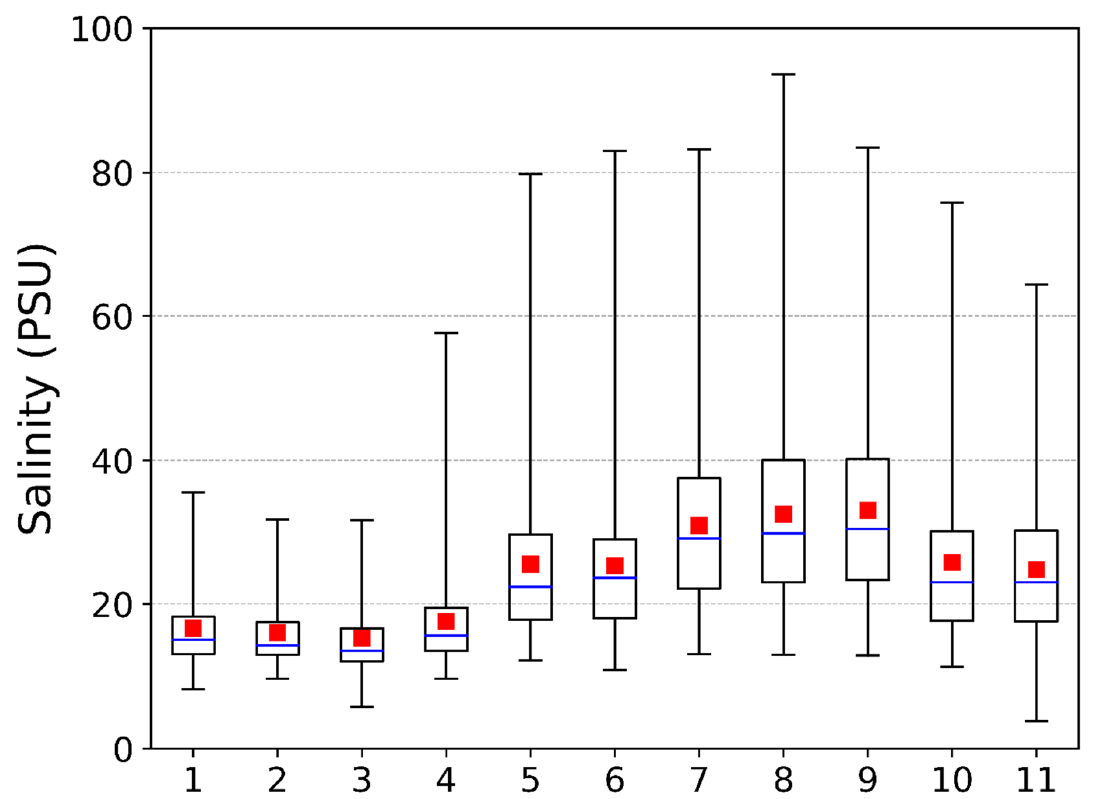
Figure 8. Salinity statistics, from 1999 to 2019, at locations 1–11 of the Vaccarès Lagoon System. The box and whisker plots (total range and 50% quartile) describe the salinity variations; the red squares represent the average salinities, and the blue lines the median values.